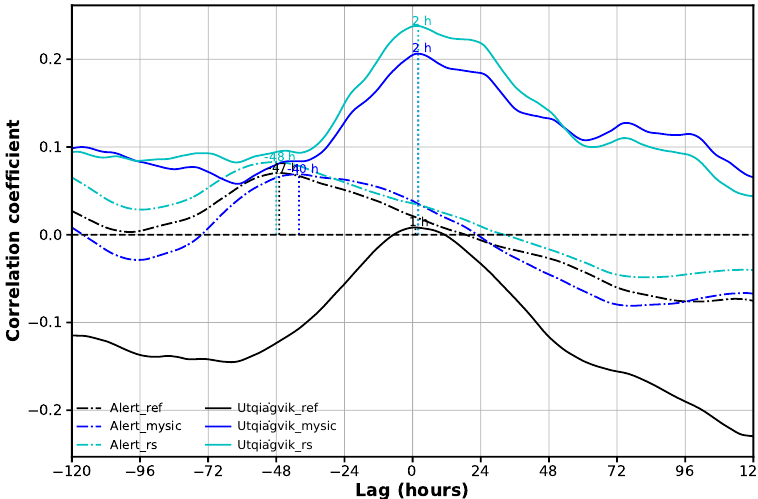
Figure 8. Time-lagged correlation coefficients between observed surface ozone and different model experiments (BrXplo_ref, BrX- plo_mysic, and BrXplo_rs) for Alert and Utqia˙gvik, respectively. Model data have been shifted with respect to the observation. Therefore, a positive lag indicates a later occurrence of low surface ozone in the model